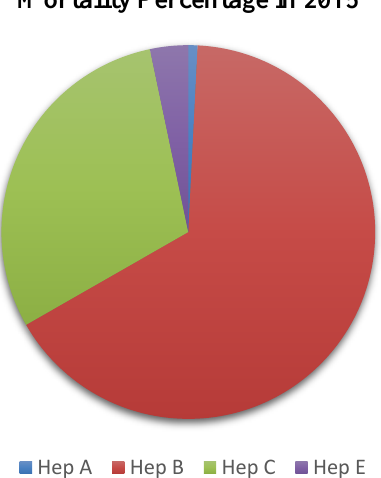
Figure 3: The pie chart represents the data for the mortality percentage of four type of hepatitis; Hep A, Hep B, Hep C and Hep E. The data retrieved from the Global Hepatitis Report,2017 (World Health Organization,